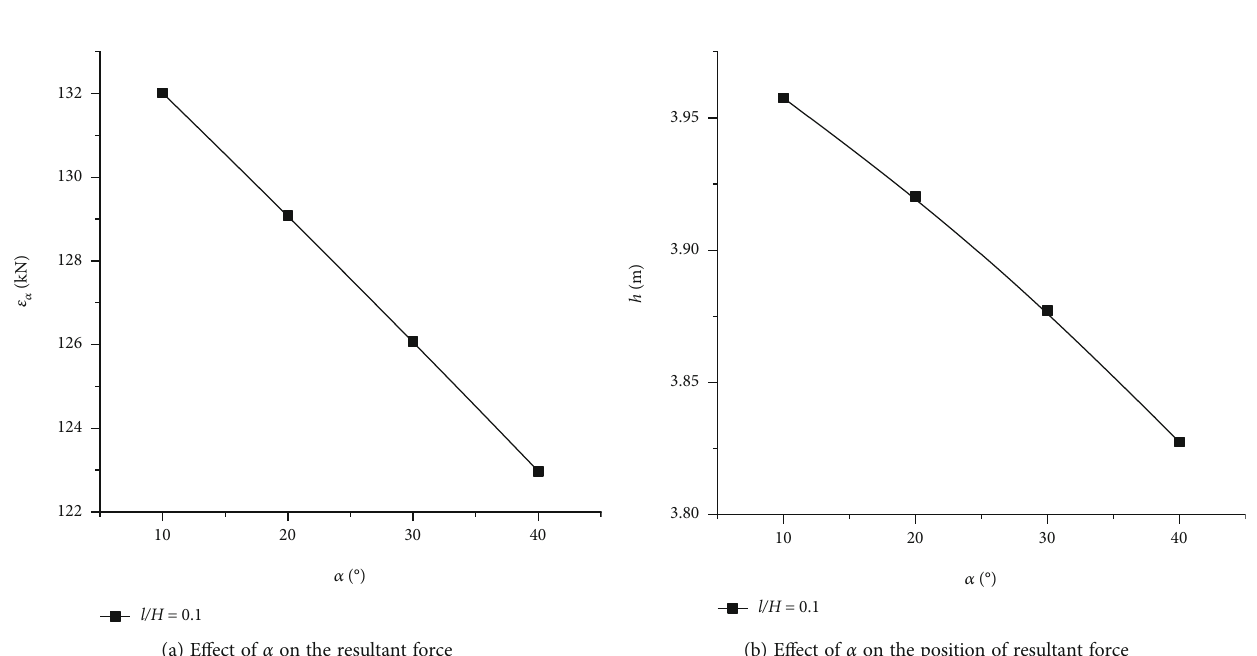
Figure 11: E ff ect of α on active earth pressure.